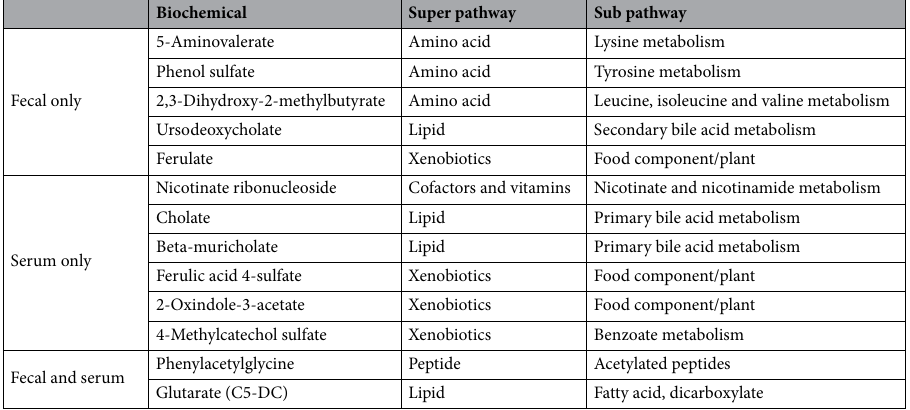
Table 2. Fecal and serum metabolites and pathways associated with the alteration of behavior.